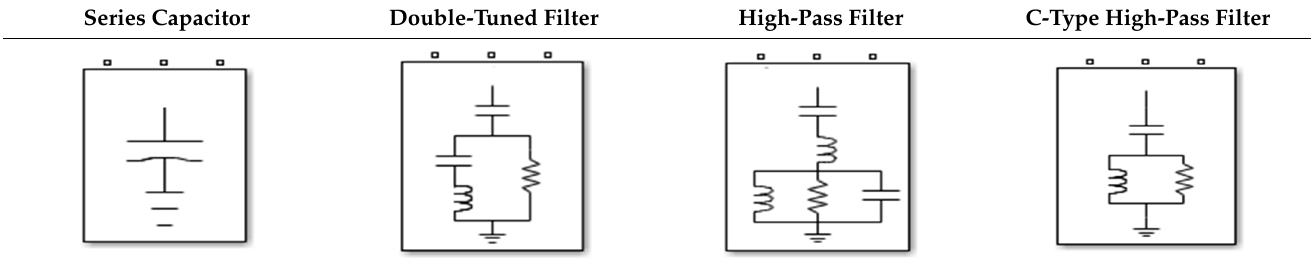
Figure 2. General block diagram representation of a power system considered for analysis.